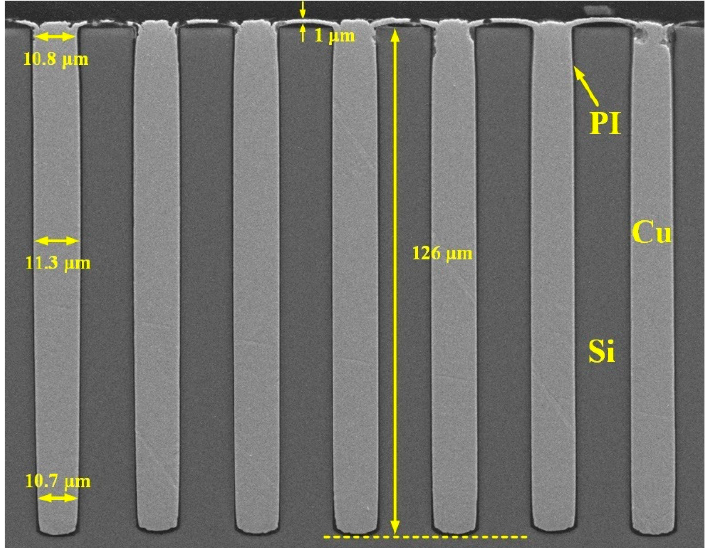
Figure 9. Cross sectional SEM image of blind TSVs after Cu electroplating.